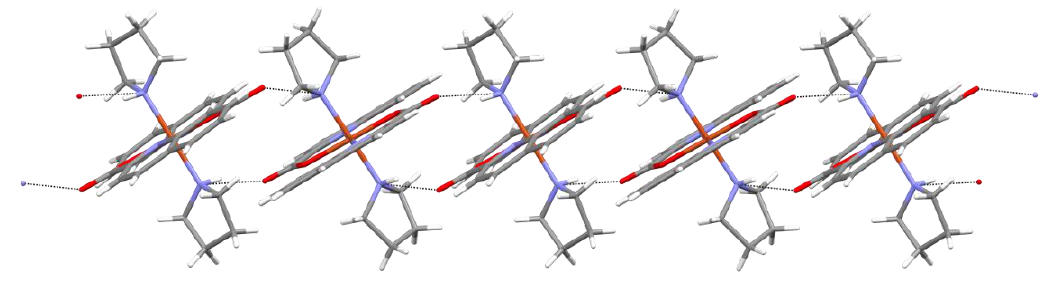
Figure 5. Section of a chain in the structure of [Cu(quin) 2 (pyro) 2 ] ( 2 ).